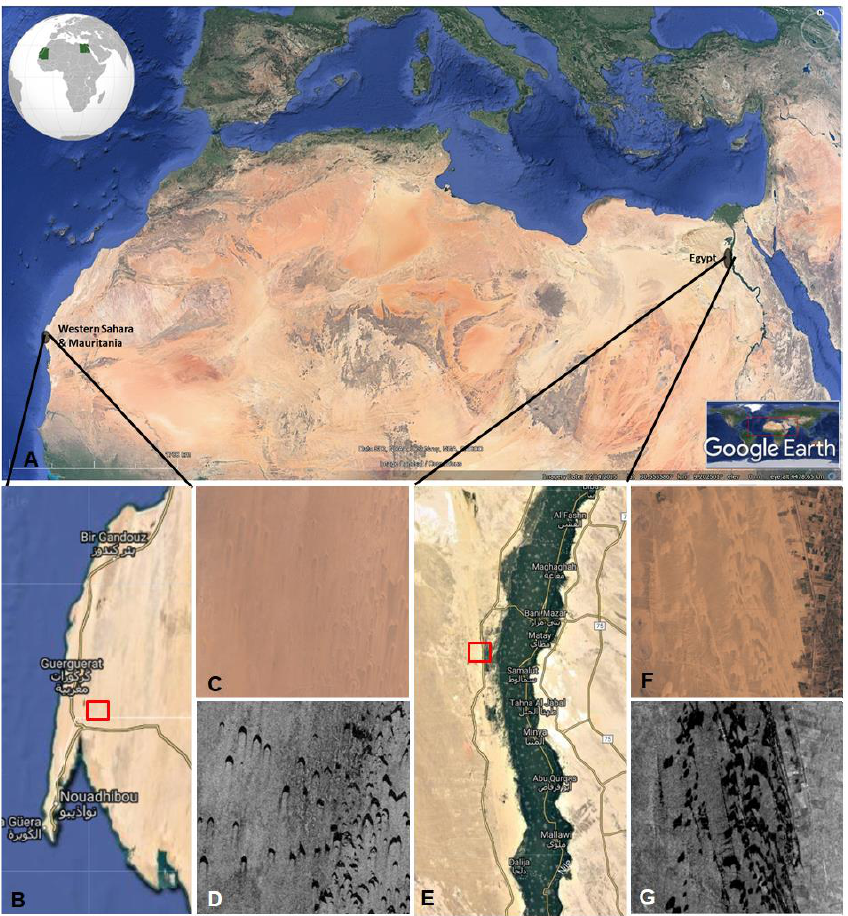
Figure 3. ( A ) Overview of the location of both areas of interest: i) in Western Sahara and the Mauritania desert ( B ) and ii) in the South Rayan dune field in Egypt ( E ). Barchan dunes viewed from optical ( C and F ) and SAR satellites ( D and G ) over the respective red rectangles from B and E. Table 1. Satellite data, acquisition dates, orbit pass, relative orbit and mean incidence angle in decimal degrees.